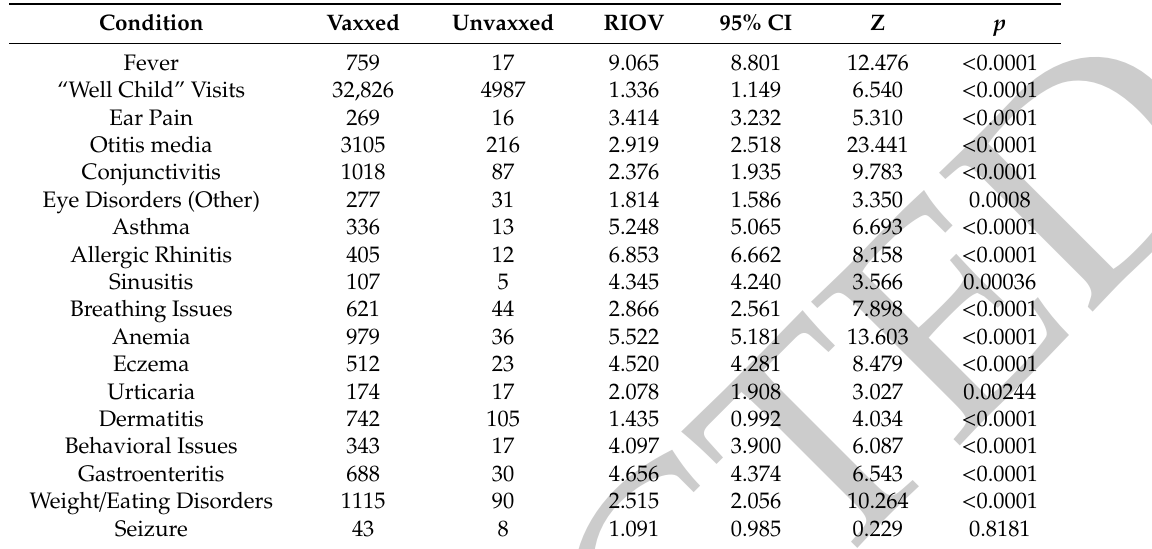
Table 2. RIOV and test of proportions of o ffi ce visits per condition for the fully vaccinated (N1 = 2763) vs. (never) unvaccinated (N2 = 561) groups comparison: these results are not adjusted for days of care. CI = confidence